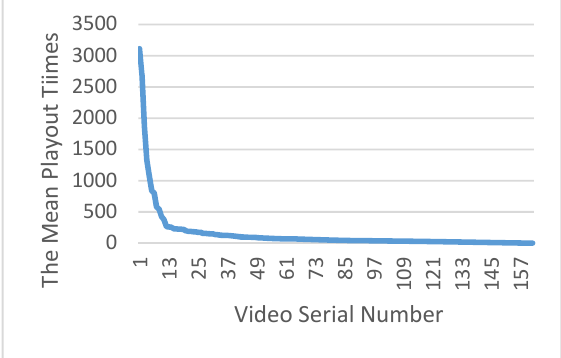
Figure.2 Distribution of the video popularity